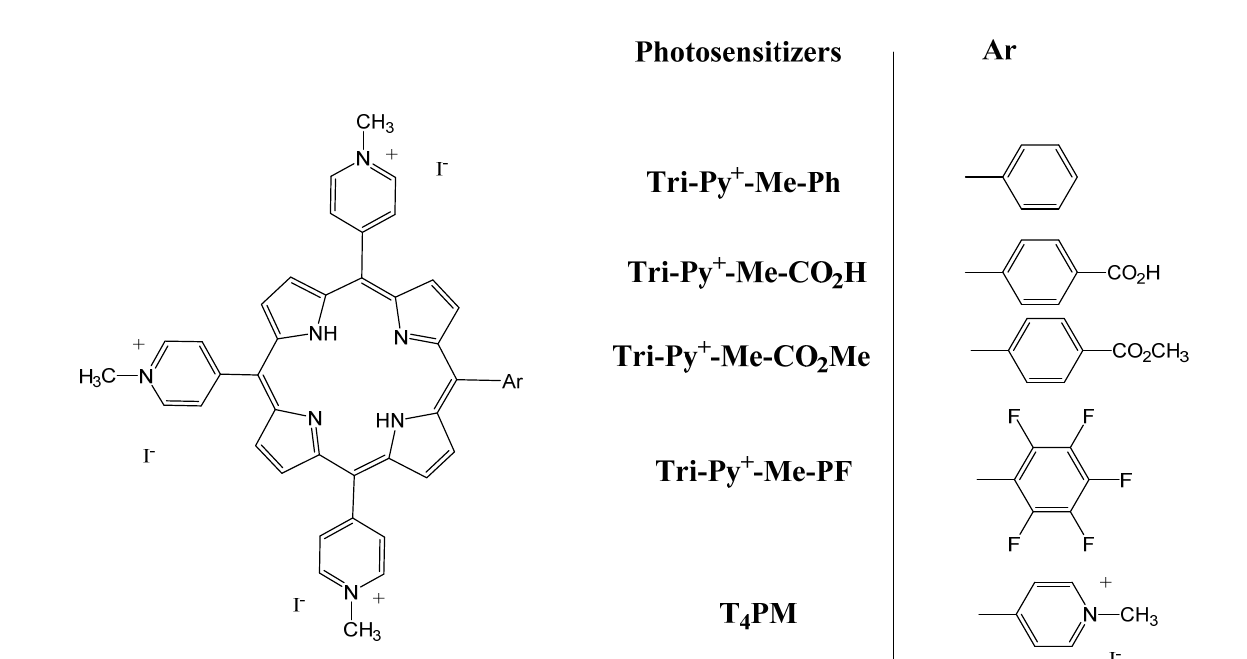
Figure 6. Cationic porphyrin derivatives used for PDT of human colon cancer cells. Chemical structure of 5-phenyl-10,15,20-Tris(1-methylpyridinium-4-yl)porphyrin tri-iodide (Tri-Py + –Me–Ph or –Ph); 5-(4-carboxyphenyl)-10,15,20-Tris(1-methylpyridinium-4-yl)porphyrin tri-iodide (Tri-Py + –Me–CO 2 H or –CO 2 H); 5-(4-methoxicarbonylphenyl)-10,15,20-Tris(1-methylpyridinium-4-yl)porphyrin tri-iodide (Tri-Py + –Me–CO 2 Me or –CO 2 Me); 5-(pentafluorophenyl)-10,15,20-Tris(1-methylpyridinium-4-yl)porphyrin tri-iodide(Tri-Py + –Me–PF or –PF); and 5,10,15,20-tetrakis(1-methylpyridinium-4-yl)porphyrin tetra-iodide (T 4 PM) [60].